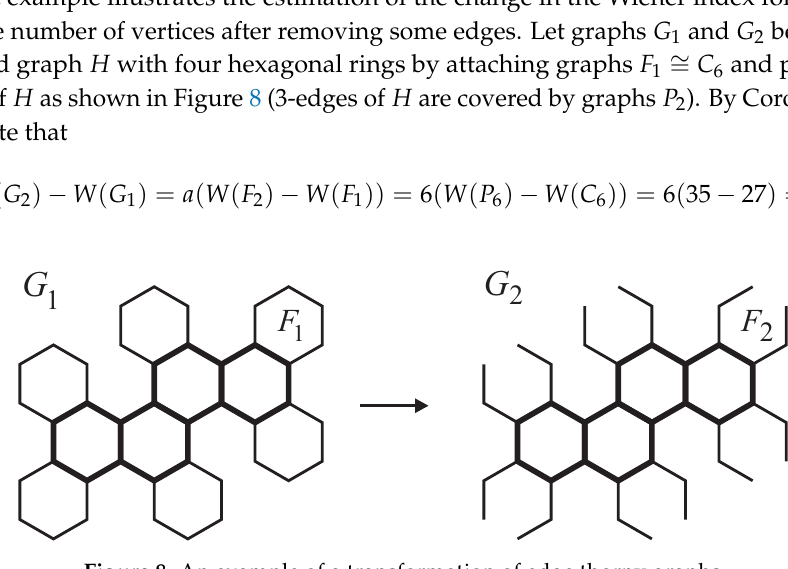
Figure 8. An example of a transformation of edge thorny